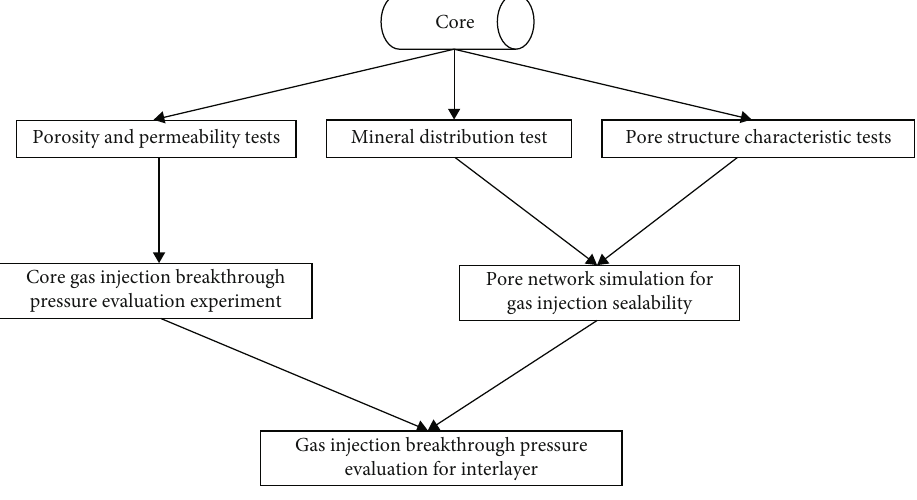
Figure 2: Experimental fl